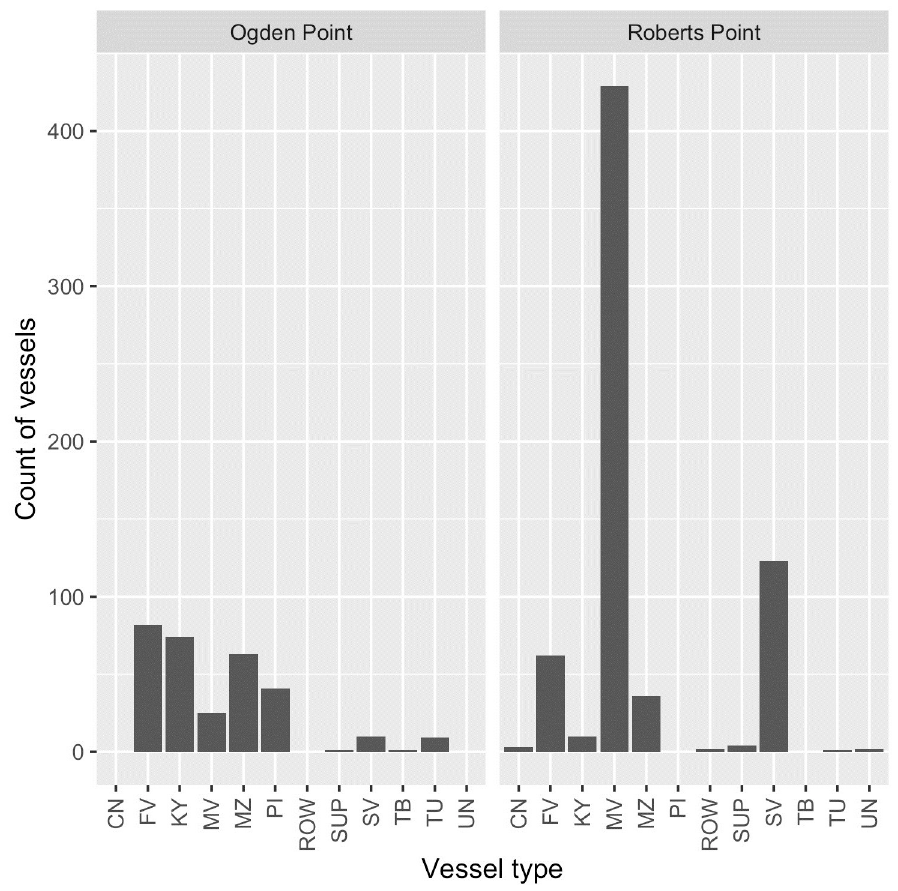
Fig 3. Vessel type count by survey site, Ogden Point (VHMBS) and Roberts Point (SHMBS), Greater Victoria, Canada. Abbreviations: CN = canoe, FV = fishing vessel, KY = kayak, MV = other motor vessel, MZ = inflatable, PI = pilot vessel, ROW = rowboat, SUP = stand-up paddle board, SV = sailboat, TB = tug and barge, TU = tug, UN = unknown (heard but not seen).